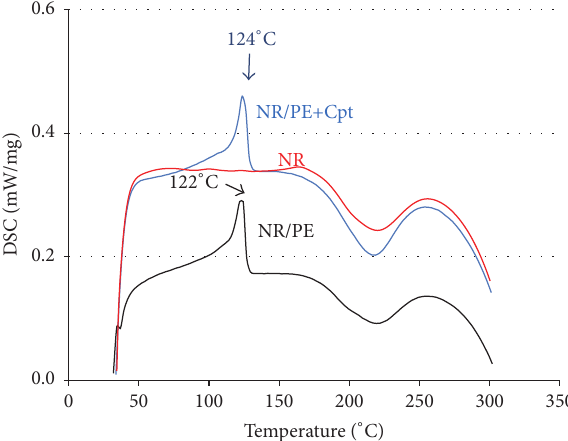
Figure 8: DSC plot of heat flow versus temperature for neat NR, NR/PE blend, and NR/PE blend treated with